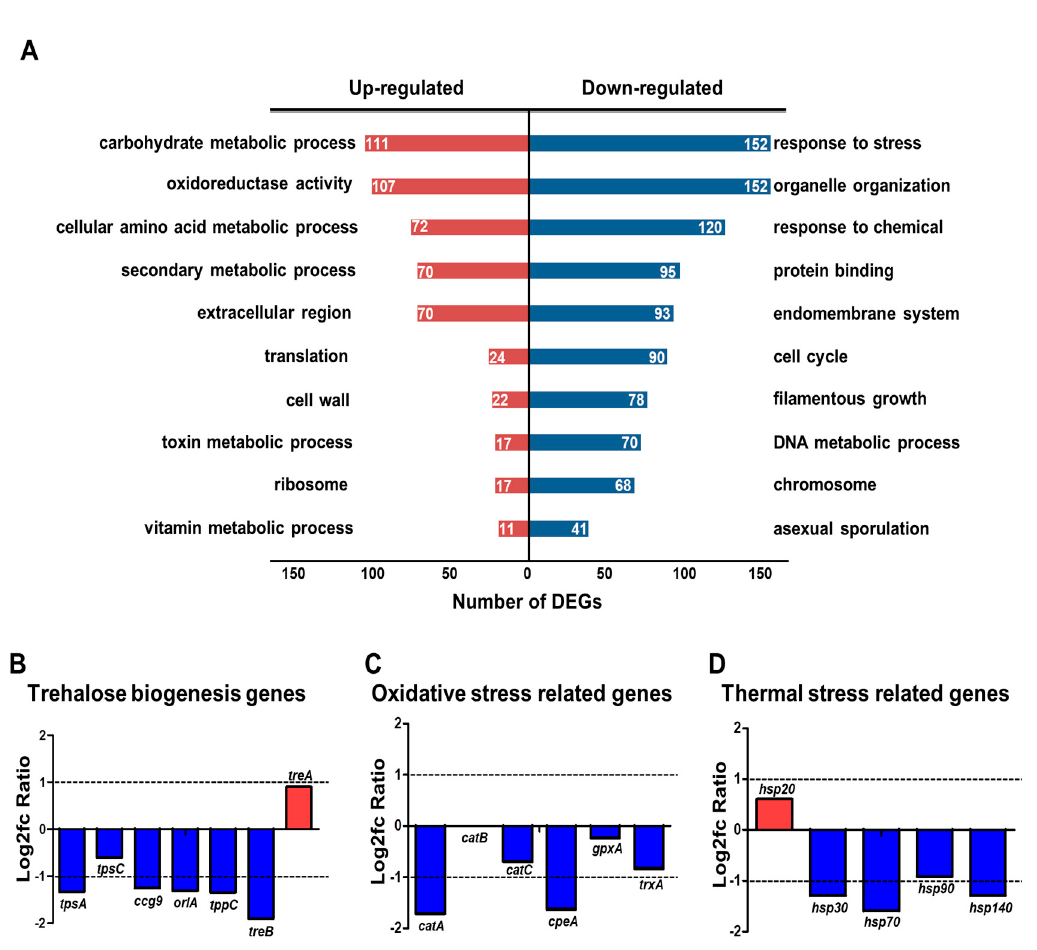
Figure 1. Transcriptomic analysis in hbxB deletion mutant conidia. ( A ) Gene ontology (GO) term enrichment analysis of upregulated and downregulated genes in hbxB deletion mutant conidia. ( B – D ) mRNA expression of genes associated with trehalose biogenesis ( B ), oxidative stress response ( C ), and thermal stress response ( D ) in hbxB deletion mutant conidia.